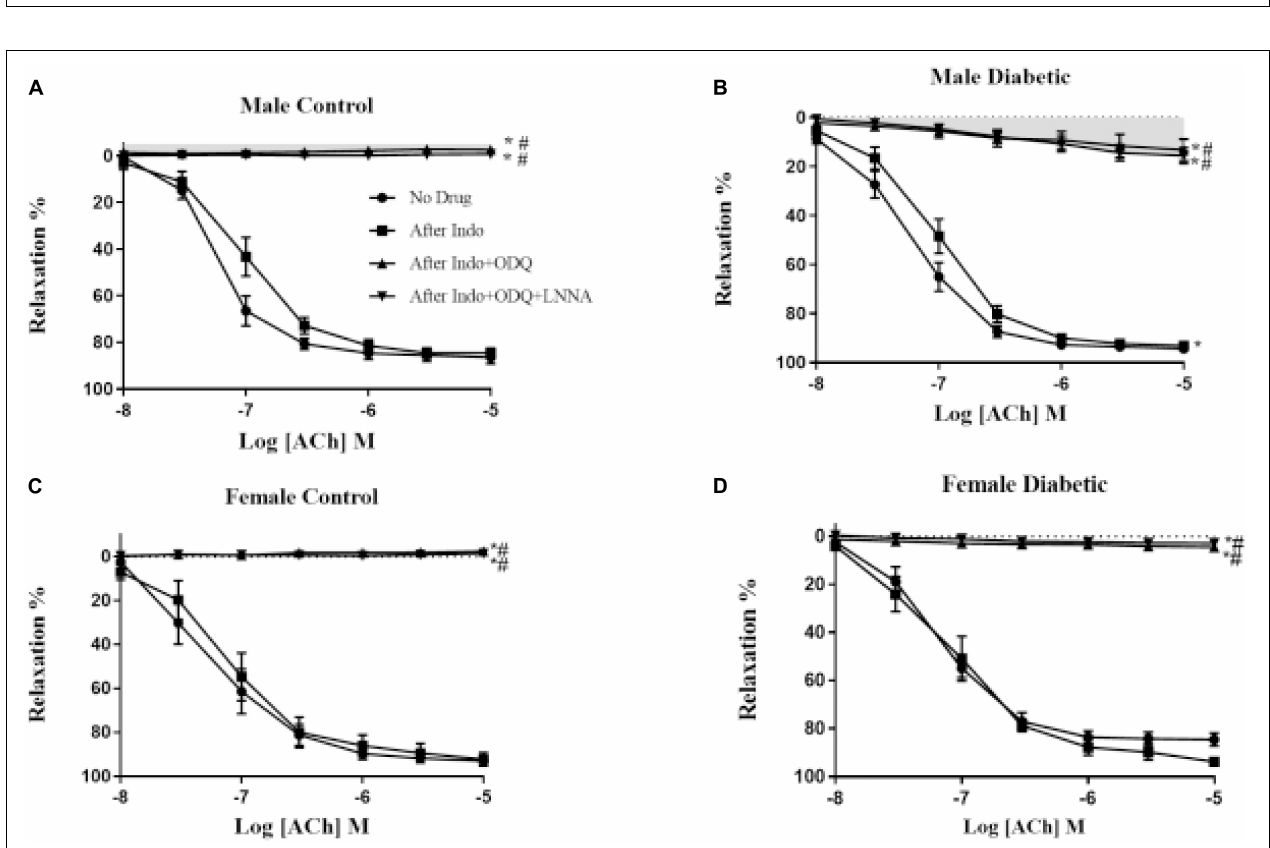
FIGURE 3 | Endothelium-derived relaxing factors (EDRF) contribution to acetylcholine (ACh) − induced relaxation responses in control and UCD-T2DM rat aorta. Effects of inhibiting cyclooxygenase, soluble guanylyl cyclase and nitric oxide synthase on ACh-induced vasorelaxation in aortic rings taken from (A) male control and (B) male diabetic, (C) female control and (D) female diabetic rats. ACh relaxation was measured in the presence of indomethacin (Indo, 10 µ M), followed by addition of ODQ (10 µ M), and then with N-nitro-L-arginine (L-NNA; 100 µ M). Data are expressed as mean ± SEM. * p < 0.05 vs. no drug; # P < 0.05 vs. Indo; analyzed using two-way ANOVA with repeated measures followed by Bonferroni post hoc test (n = 5–8 per group). Light gray shaded area: contribution of endothelium-derived hyperpolarizing factor (EDHF)-type to endothelium-dependent vasorelaxation (EDV).